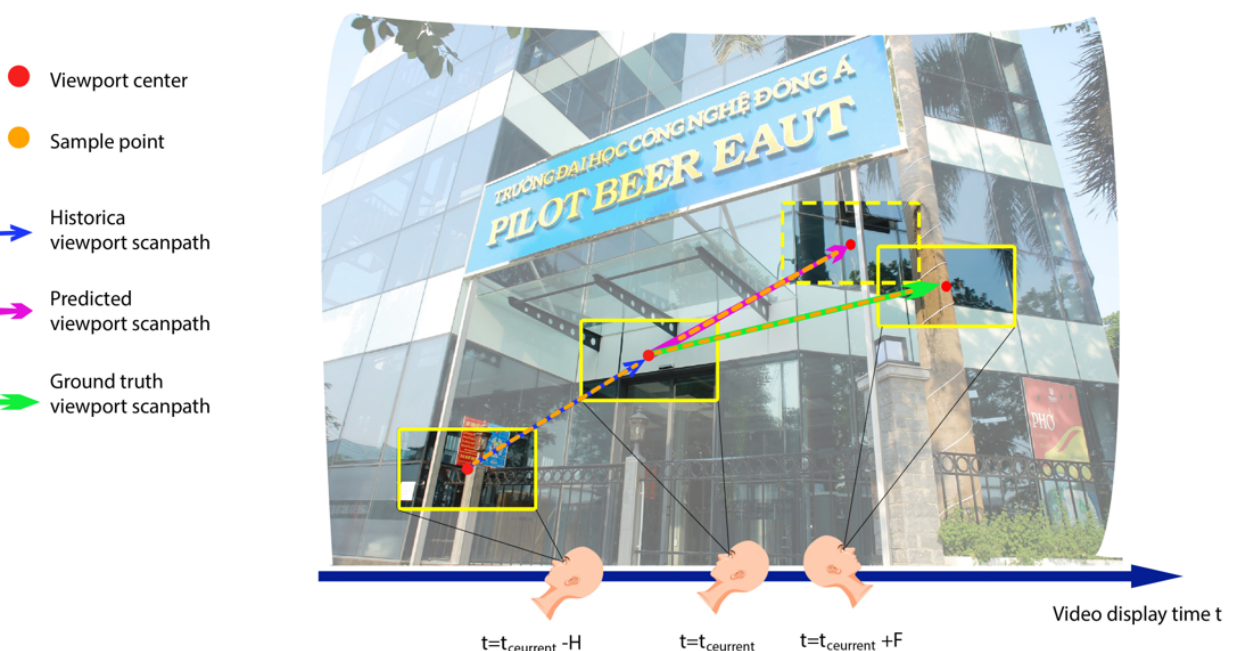
Figure 1. The GLVP model compares the viewport sweep in the past H-second to predict the viewport sweep in the future F seconds. adaptive streaming. Prediction performance is